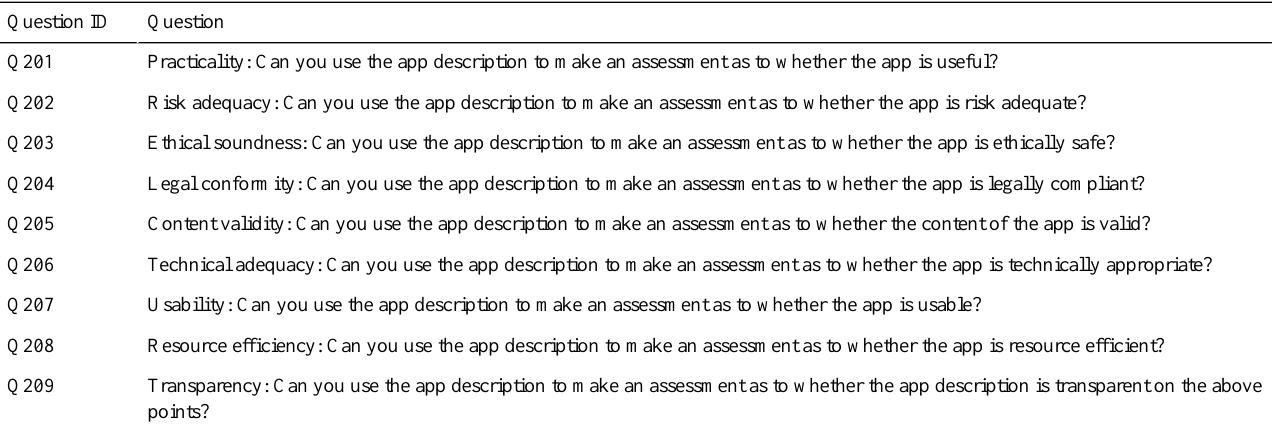
Table 3. Questions, via Q2 a , used for determining whether the presented app descriptions contained information related to the nine quality principles, following those employed in Albrecht et al